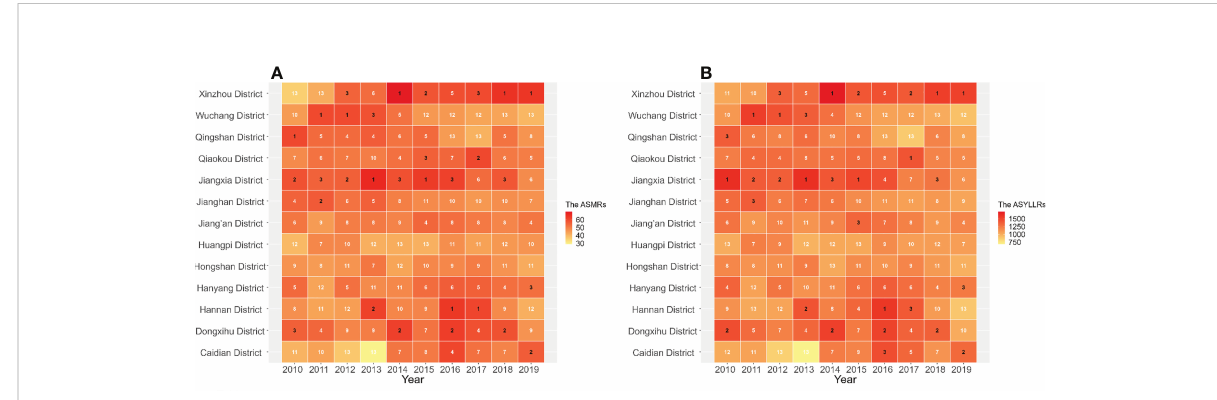
FIGURE 4 Changes of the ASMRs (A) and ASYLLRs (B) for lung cancer and the corresponding ranks of the ASRs in the population of 13 administrative regions in Wuhan,